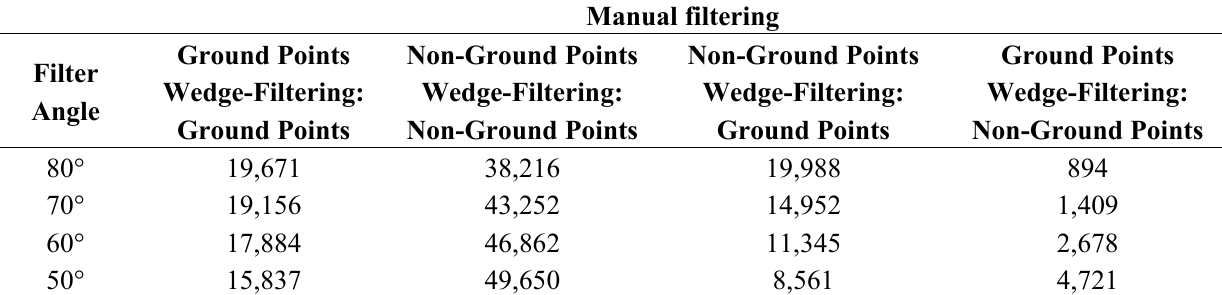
Table 2. Point classification of the four new calculated models (80, 70, 60 and 50 degree of filter angle) compared with the manually filtered terrain